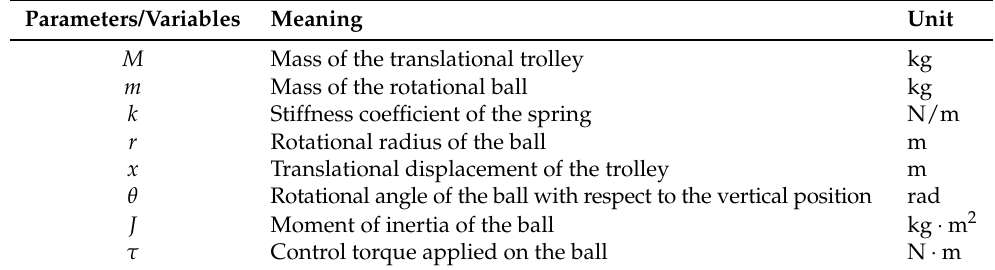
Table 1. Physical parameters and variables of the TORA system.